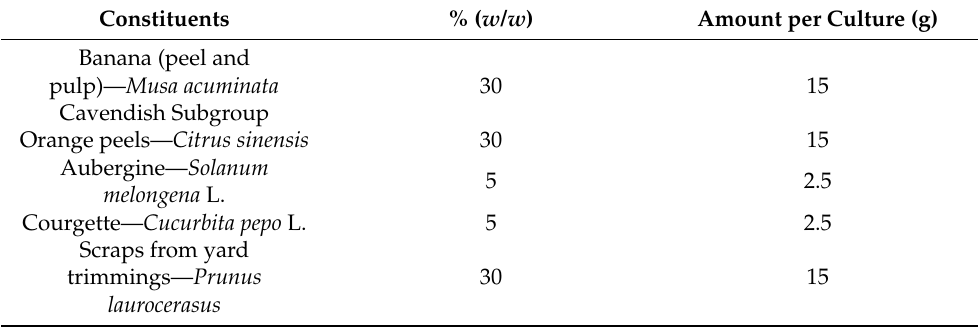
Table 1. Components of the culture substrate for solid state fermentation of Aspergillus niger. Constituents % ( w/w